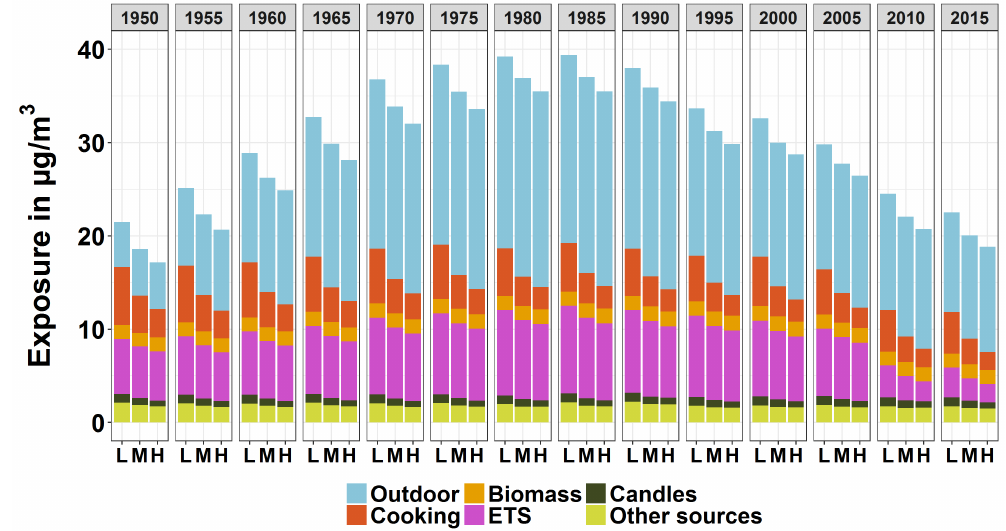
Figure 6. Population-weighted arithmetic mean PM 2.5 exposure by source and income level for European countries from 1950 to 2015. The “L”, “M” and “H” stand for the “Low”, “Median” and “High” level of income.